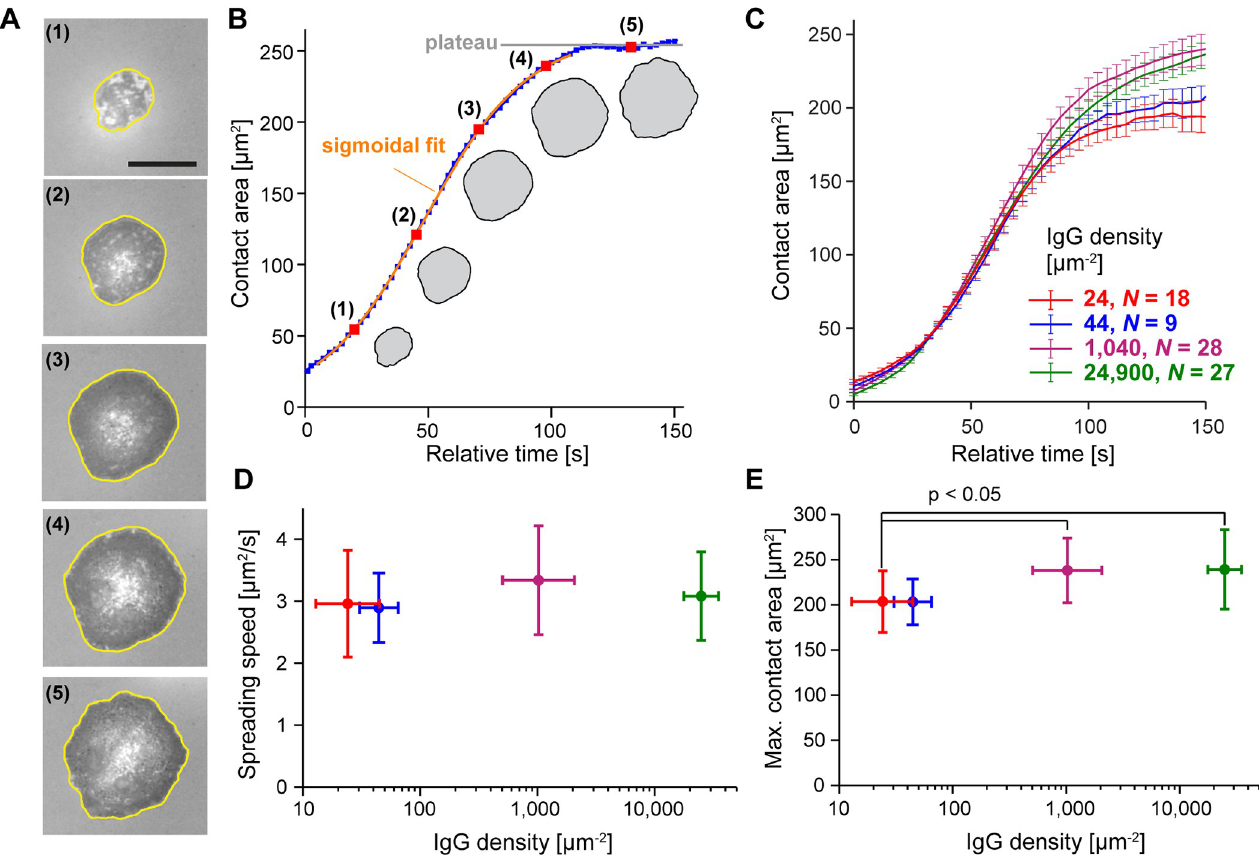
Fig 2. Summary of experimental results. (A) The contact region of a spreading neutrophil was imaged using reflection interference contrast microscopy (RICM). Contact regions in this example are traced in yellow. The scale bar in the first image denotes 10 μ m. (B) Contact area is plotted as a function of time for the spreading cell shown in (A). The spreading speed is defined as the maximum slope extracted from a sigmoidal fit, and the maximum contact area is given by averaging the contact area at the plateau. (C) Mean contact area was computed at discrete time values for aligned curves of cells spreading on different densities of IgG. Mean quantified IgG densities are reported in the figure legend as IgG molecules per μ m 2 . Error bars represent standard error of the mean. (D) Average spreading speed was quantified for the different IgG densities. There is no significant difference between mean slope values. (E) Maximum contact area increases slightly as a function of IgG density. Statistically significant differences in maximum contact area values were verified using ANOVA followed by a Tukey post hoc test. Error bars in both (D) and (E) indicate standard deviation. The IgG density was quantified for each condition as described in [24].